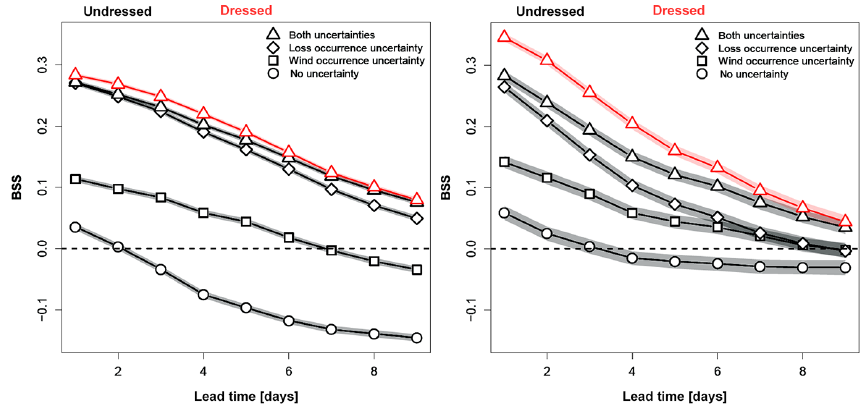
Figure 5. Lead time dependent Brier skill score (BSS; employing climatology as the reference forecast) for events with a loss ratio exceeding low threshold (0.0001‰) (left panel) and loss events with a loss ratio exceeding high threshold (0.001‰) (right panel) for the period 2006– 2009. Shown in black symbols are verification results for the four different set-ups, red triangles show verification results using the ensemble dressing post processing method. 90% confidence intervals from a bootstrapping method are shown as shaded